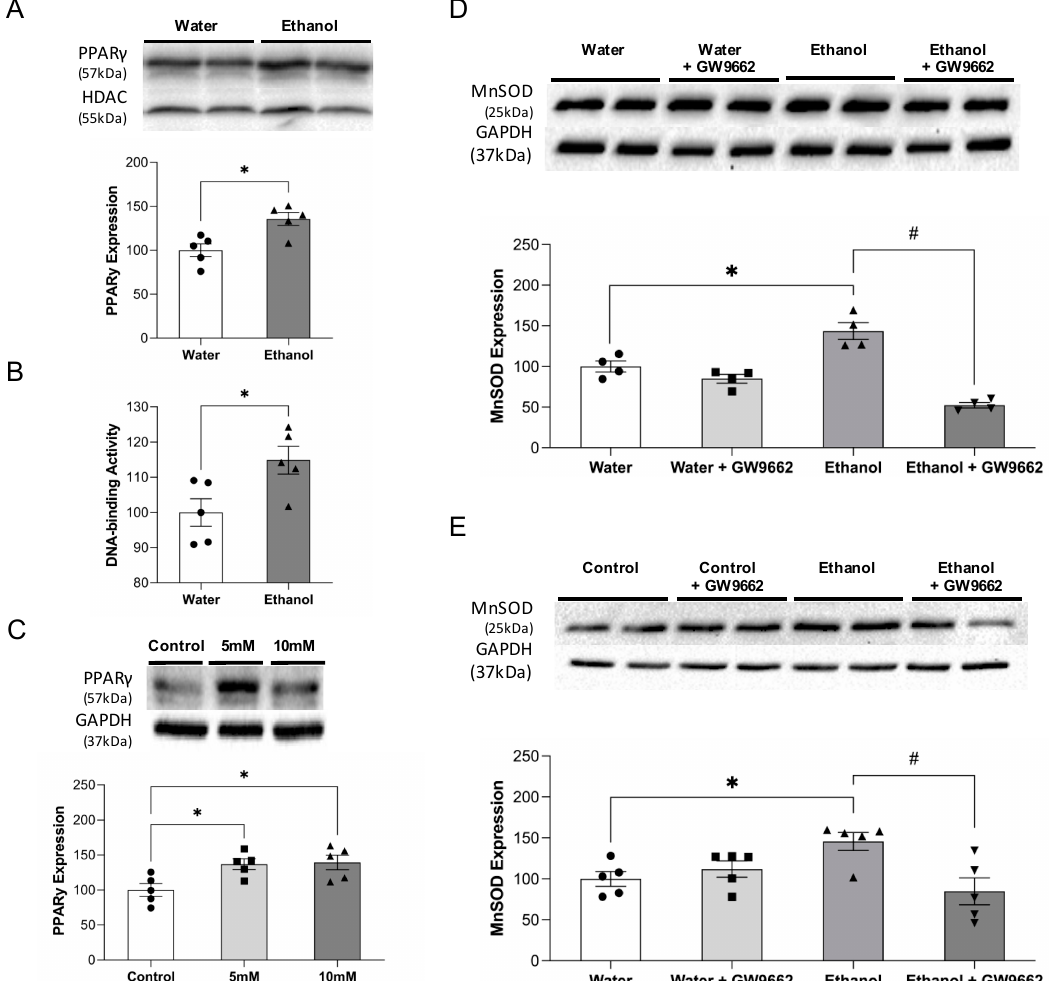
Figure 1. Effect of alcohol on nuclear protein expression and DNA-binding activity of PPAR γ and protein expression of MnSOD. ( A ) Nuclear protein expression of PPAR γ in the cerebral cortex of water and 0.7 g/kg/day ethanol-fed mice. Values are means ± SE. * p < 0.05. Analyzed using one-way ANOVA with Dunnett’s post hoc. ( B ) Nuclear DNA binding activity of PPAR γ in the cerebral cortex of water and 0.7 g/kg/day ethanol-fed mice. Values are means ± SE. * p < 0.05. Analyzed using one-way ANOVA with Dunnett’s post hoc. ( C ) Protein expression of PPAR γ in MBMVECs exposed to ethanol for 7 days. Values are means ± SE. * p < 0.05. Analyzed using one-way ANOVA with Dunnett’s post hoc. ( D ) Protein expression of MnSOD in the cerebral cortex of water and 0.7 g/kg/day ethanol-fed mice with or without GW9662 treatment. Values are means ± SE. * p < 0.05 vs. Water. # p < 0.05 vs. Ethanol. Analyzed using two-way ANOVA with Tukey’s post hoc. ( E ) Protein expression of MnSOD in 10 mM ethanol-exposed mice in the presence and absence of GW9662. Values are means ± SE. * p < 0.05 vs. Control. # p < 0.05 vs. Ethanol. Analyzed using two-way ANOVA with Tukey’s post